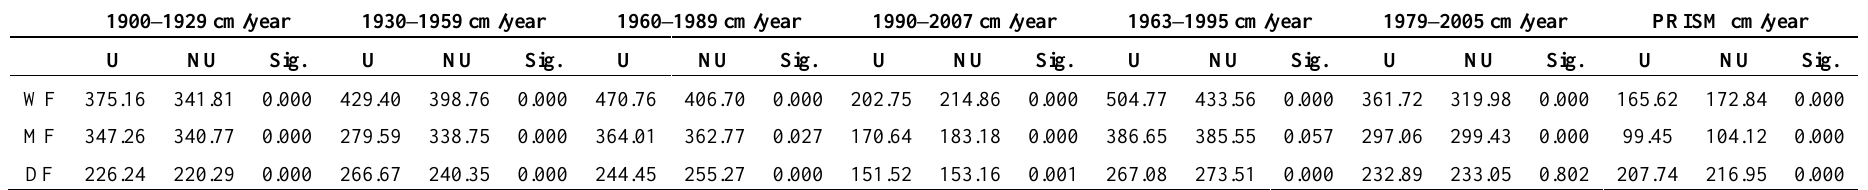
Table 8. Yearly Average Total Precipitation for each period and its corresponding Urban vs. Non urban T-test significance values: 270 m grid size.